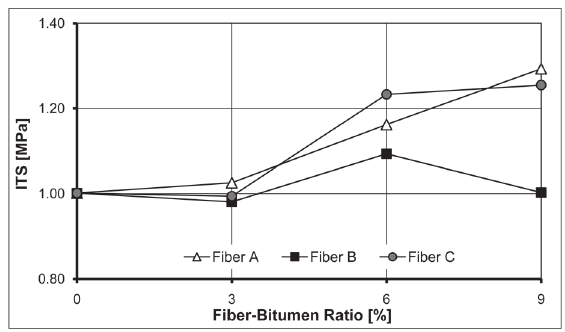
Fig. 11. Indirect tensile strength of bituminous mixtures at 20 °C